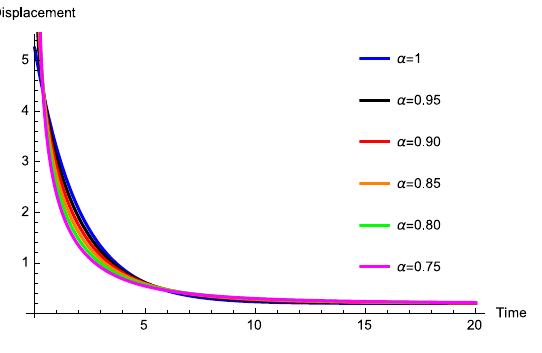
Figure 1. Numerical simulation for Equation (14) considering different values of α , arbitrarily chosen.